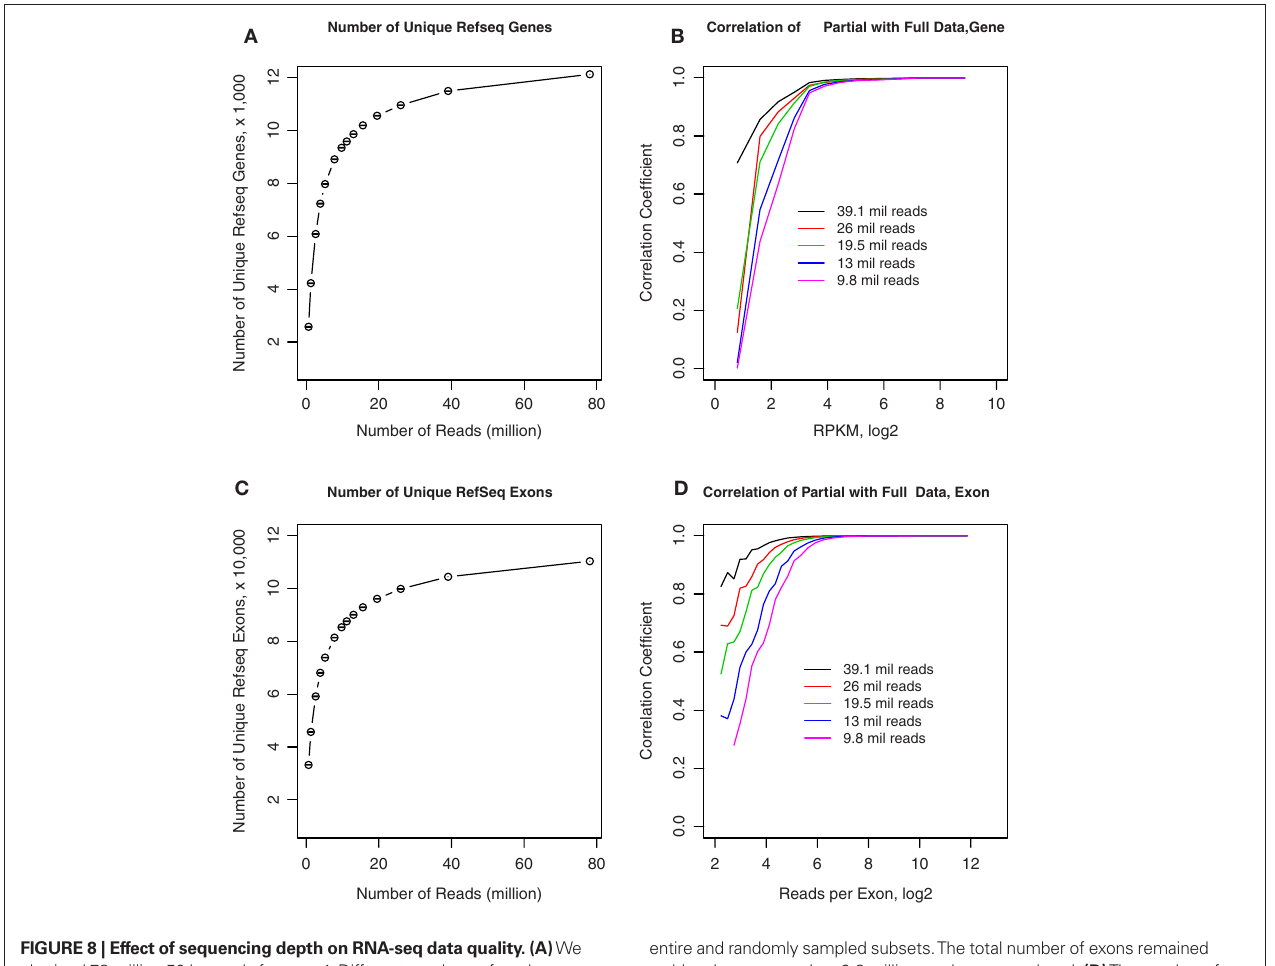
FiGuRe 8 | effect of sequencing depth on RNA-seq data quality. (A) We obtained 78 million 50-bp reads from rat 1. Different numbers of reads were randomly sampled from the full data set of 78 million reads. The number of unique RefSeq genes was calculated from the full and randomly sampled subsets. The total number of unique genes remained stable when greater than 9.8 million reads were analyzed. (B) Gene expression levels calculated from these randomly selected subsets were highly correlated with the full data set when RPKM is above ∼ 2 3 , despite gradual decreasing the number of reads to 9.8 million. (C) The number of unique exons detected were calculated for the